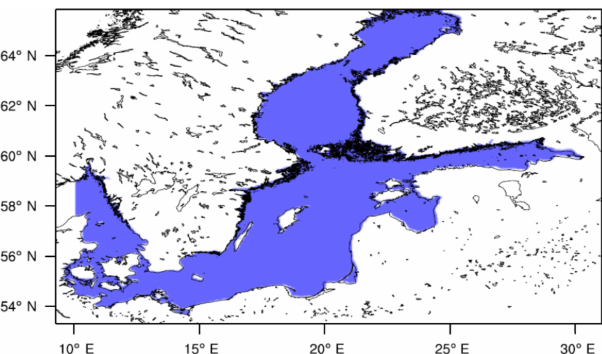
Figure 1. Geographic map of the study domain for the CTM comparison, spanning from latitude 53.40 ◦ N (south) to 65.80 ◦ N (north) and longitude 9.00 ◦ E (west) to 31.10 ◦ E (east). The area of the Baltic Sea used in this study is shown in